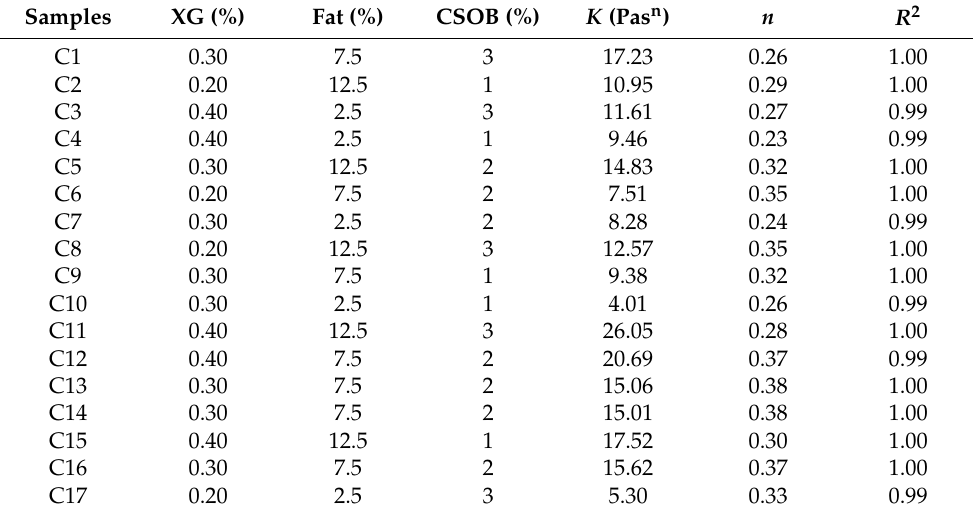
Table 1. Steady shear power-law parameters of the ice cream mixtures contained CSOB with ingredi- ent compositions. Samples XG (%) Fat (%) CSOB